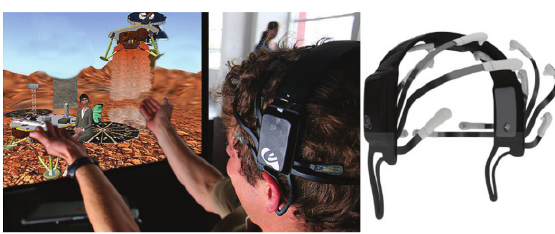
Figure 5. Brain–based and hand gesture interfaces for controlling objects in the